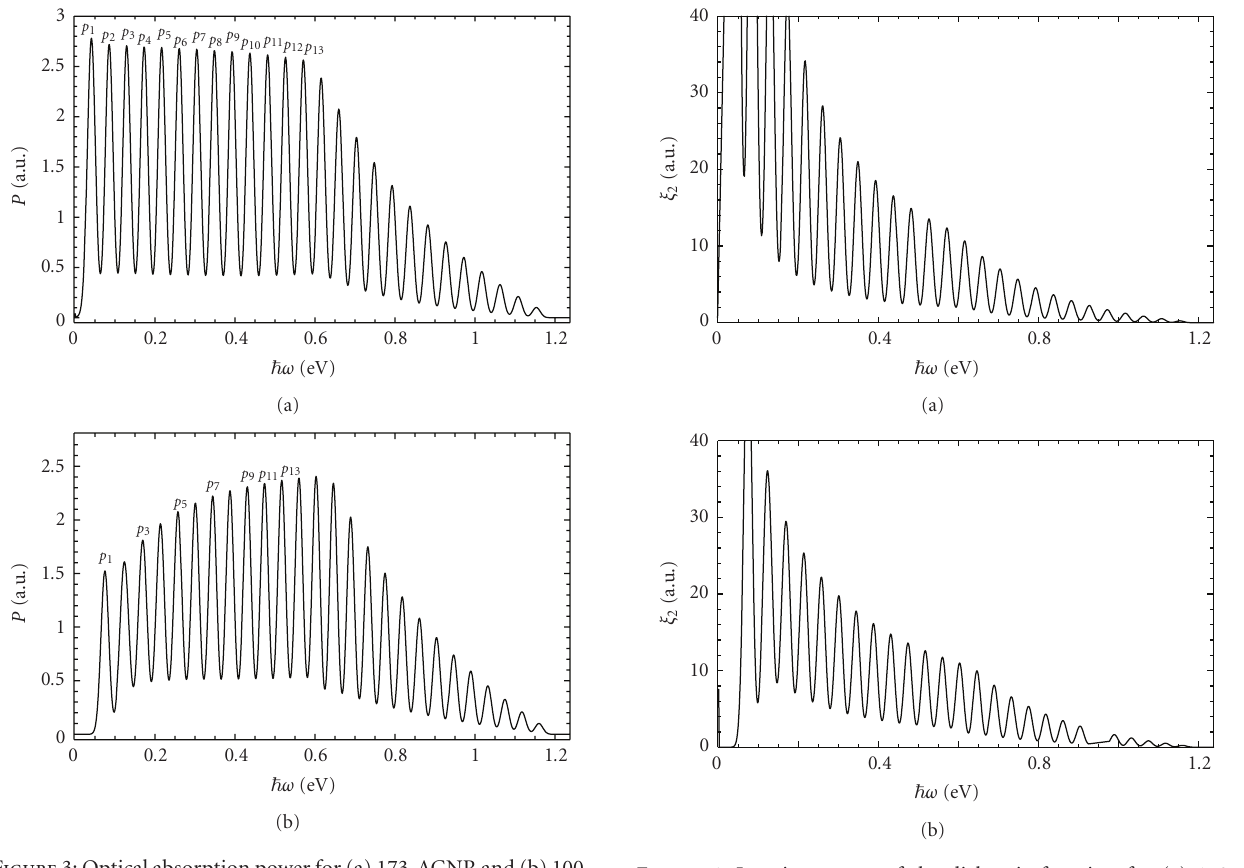
Figure 4: Imaginary part of the dielectric function for (a) 173- AGNR and (b) 100-ZGNR as a function of photon